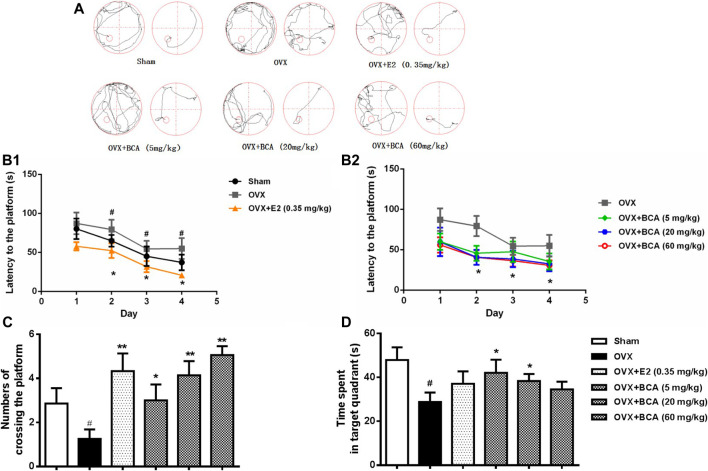
The effects of BCA on learning and memory of OVX rats in the Morris water-maze (MWM) test. (A) Representative swimming trajectory of rats during the acquisition training (left: day 1, right: day 4). (B) The escape latency of navigation during the 4-days acquisition training. (C) The number of crossings into the target quadrant in the probe trail test. (D) The time spent in the target quadrant in the probe trial test. Values shown are means ± S.E. #
p < 0.05 vs. Sham; *p < 0.05, **p < 0.01 vs. OVX alone; n = 10.